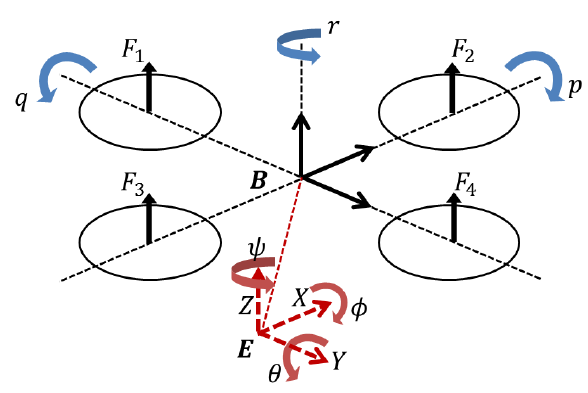
Figure 1. The generalized coordinates and thrusts of a